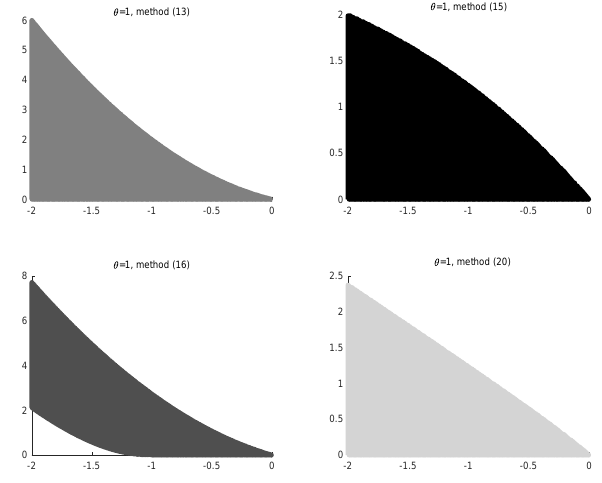
Figure 8. Mean-square stability regions in the ( x , y )-plane with respect to the convolution test Equation (12) for z = − 2 and ϑ = 1.